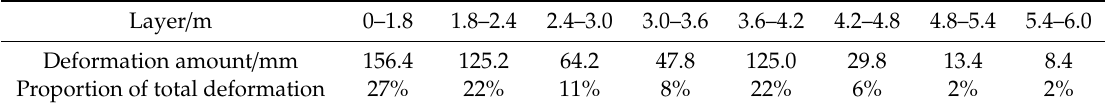
Figure 12. Curves of roadway roof deep displacement of Station II. Table 4. Distribution of roof deformation in each layer of Station II.